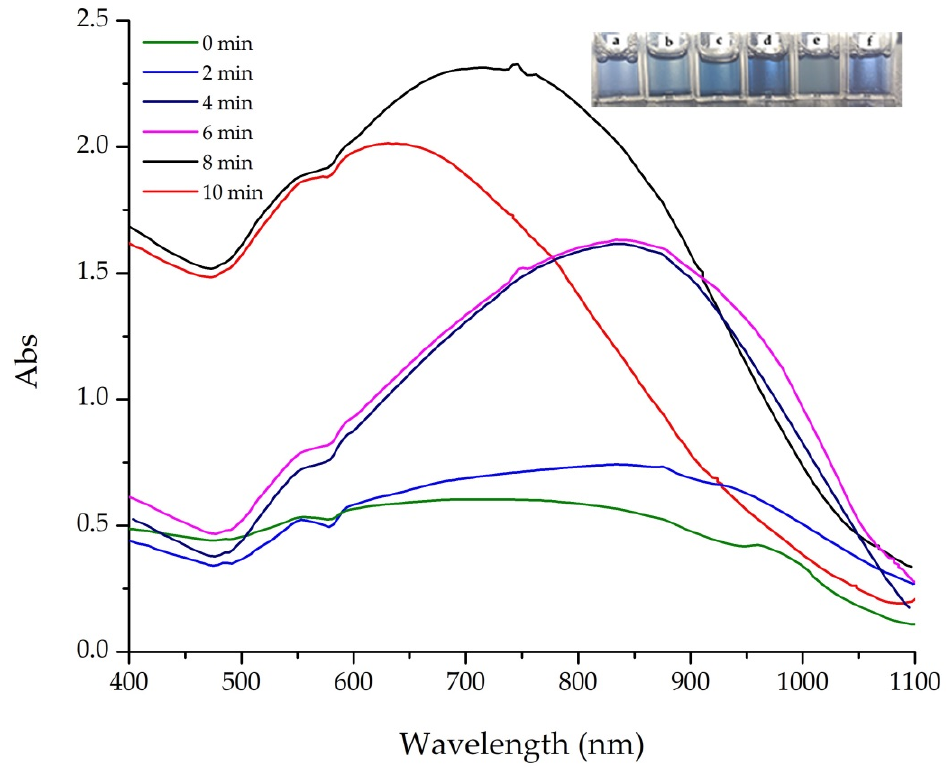
Figure 9. Absorption spectra of GNS prepared in different sonication time—( a ) 0 min, ( b ) 2 min, ( c ) 4 min, ( d ) 6 min, ( e ) 8 min and ( f ) 10 min.